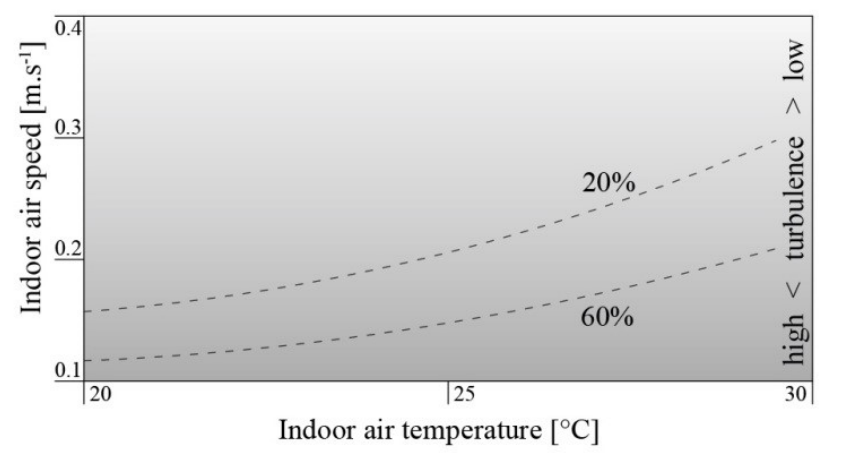
Figure 3. Illustrative exemplification of standard-based specification of an IEQ indicator (maximum permissible air flow speed) and its value as a function of indoor air temperature and turbulence intensity (based on standards DIN EN 15251 and DIN EN ISO